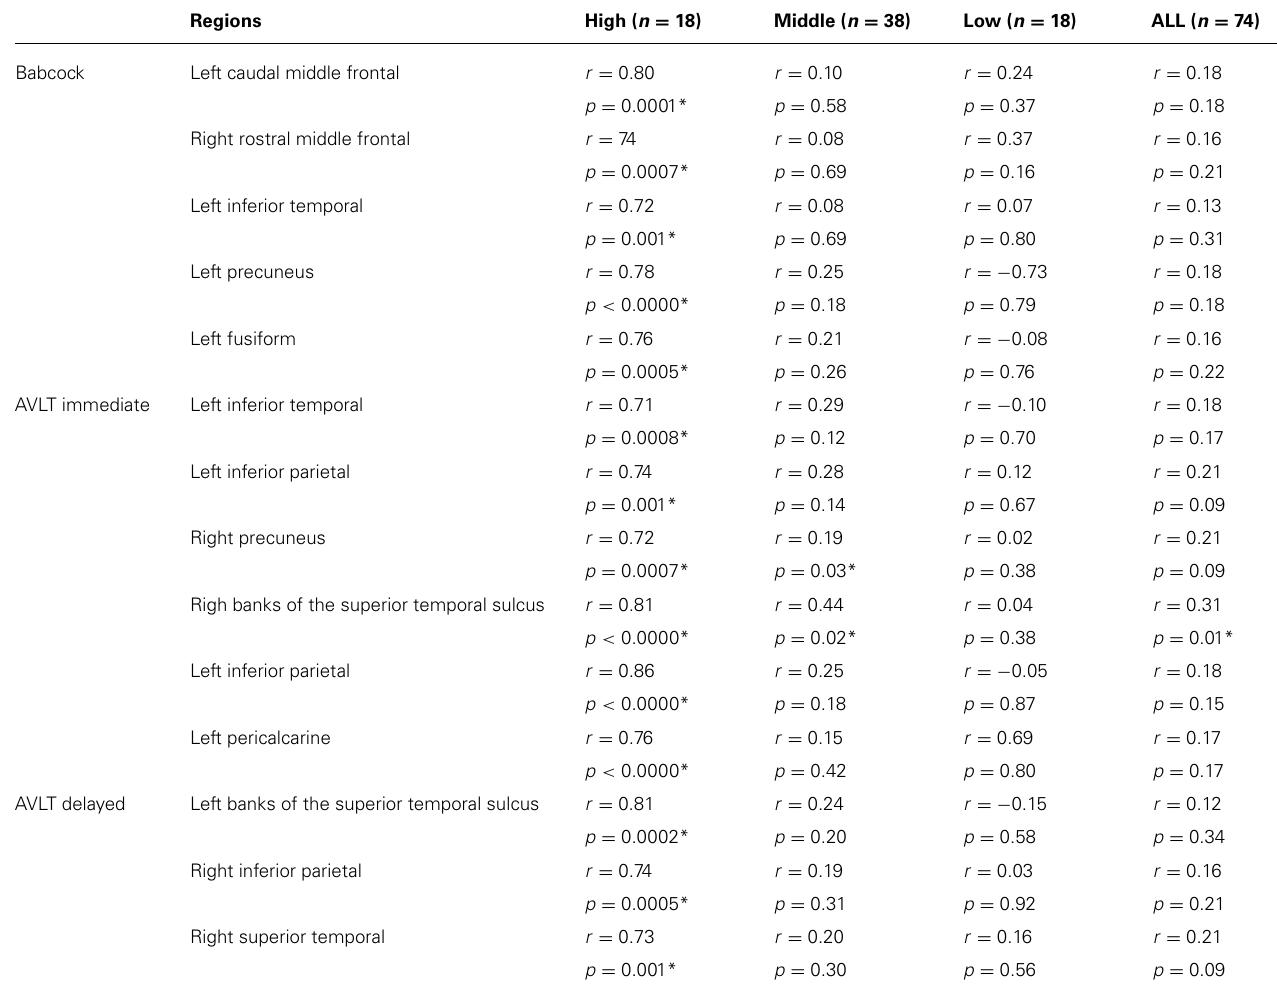
Table 3 | Correlations between neuropsychological memory tests and cortical thickness in High a3/a2 group and other groups, including whole sample